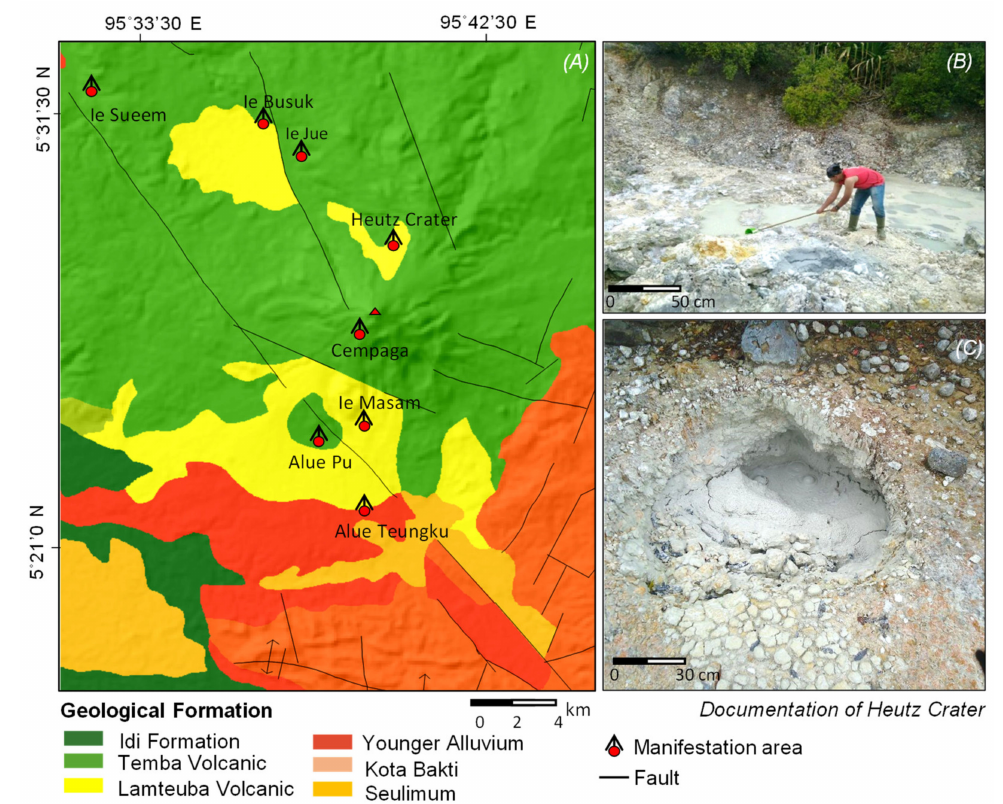
Figure 2. ( A ) Geological map of the Seulawah Agam volcano [42]; ( B ) photo documentation of the Heutsz crater emitting sulfur oxide gas in an area close to the top of volcanic with an altitude of 700 m asl; and ( C ) documentation of a mud pool with a temperature of 89.05 ◦ C [28]. At the Heutz crater area, some neo-formational minerals were also found, such as sulfur, sulfatara, mudpole, and fumarole, indicating the volcanic activities of Seulawah Agam